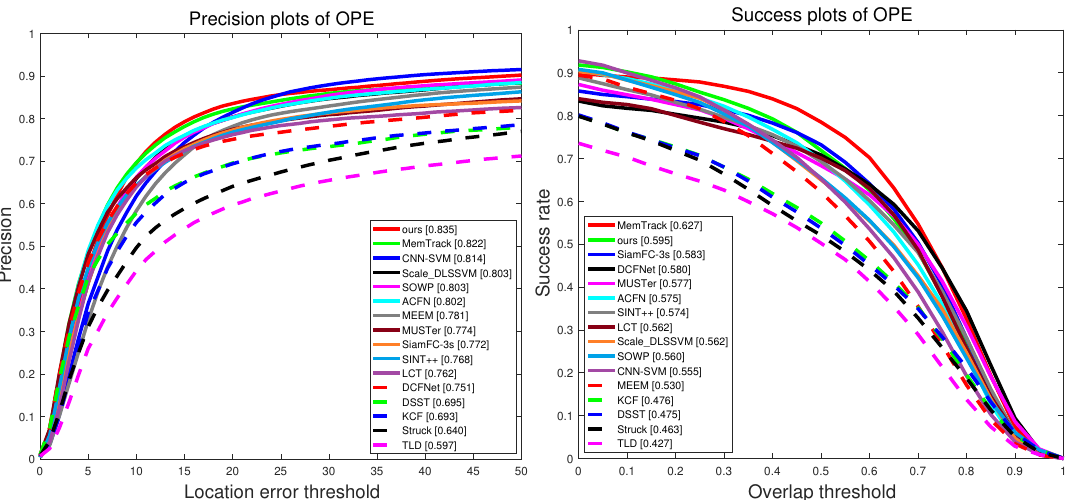
Figure 5. The evaluation results on OTB-100. The left shows precision plots, and the right is the success plots of one-pass evaluation